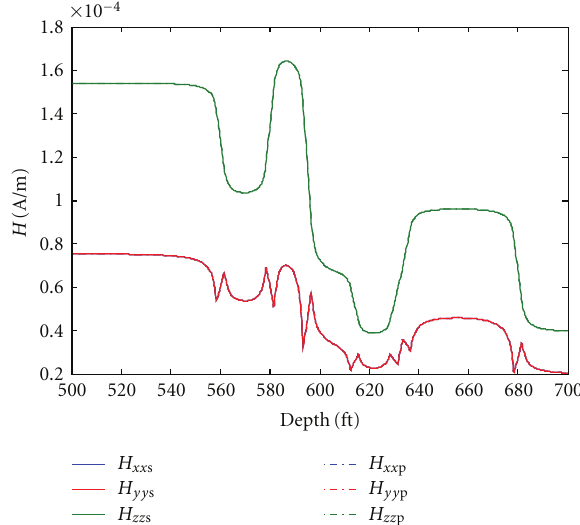
Figure 11: Comparison of the total running time between the serialized model and the parallelized model. Figure 12: Comparison of the simulated results (800 points) from the serialized and parallelized